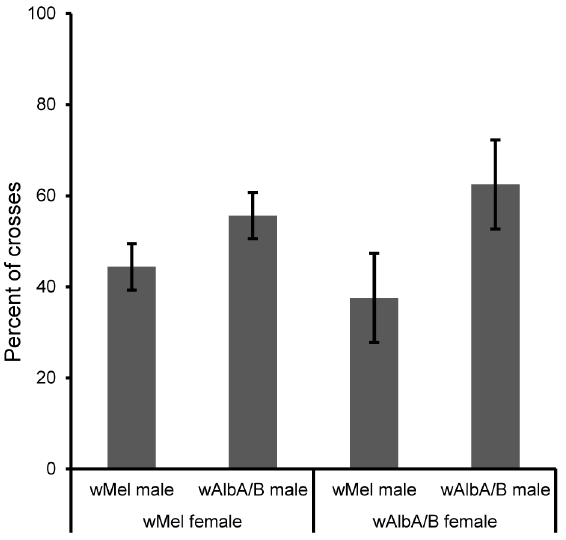
Figure 2. Longevity of Uju.wMel. The survival over time of three Ae. albopictus lines was assessed in two or three independent replicates of cages containing approximately 100 male and 100 female mosquitoes (total of 1600 mosquitoes in eight cages). A blood meal was provided at seven days, and again every 14 days. Dead mosquitoes were counted and removed every four days. Error bars show the SEM. Male Uju.wMel longevity was significantly increased compared to UjuT and Uju.wt.